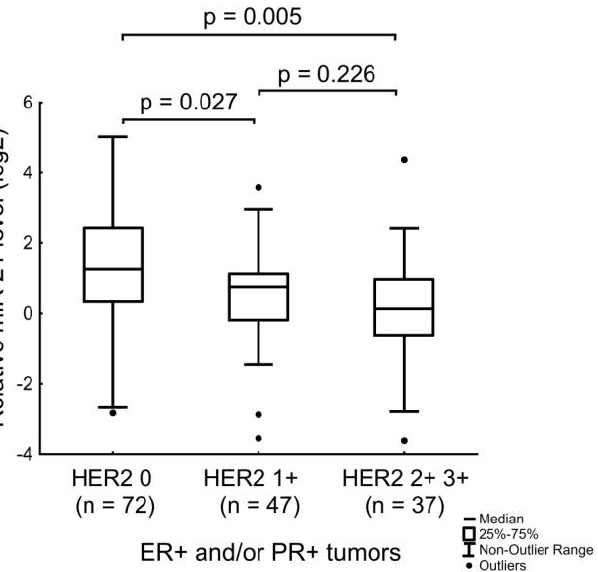
Figure 10. The relation of the miR-21 level with the HER2 expression level in ER-positive and/or PR- positive tumors. The Y axis presents the expression level (log 2 – ∆∆ Ct ); the results were normalized to the control (normal tissue).